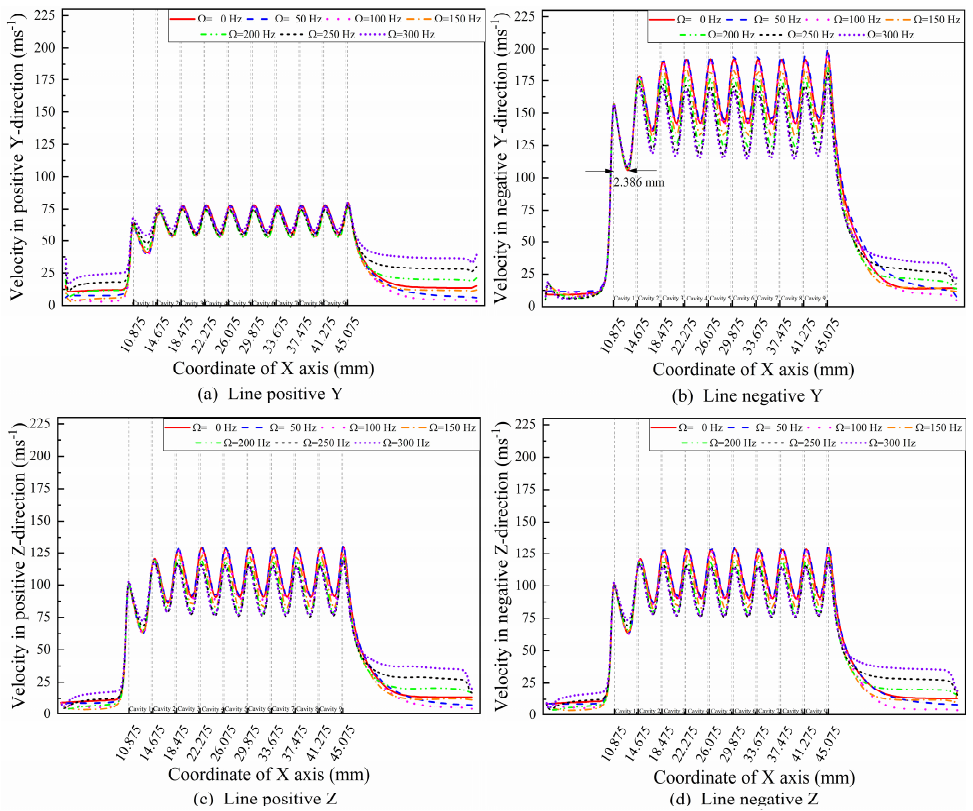
Figure 11. Velocity curves in different directions with different whirl frequencies ( ω = 5000